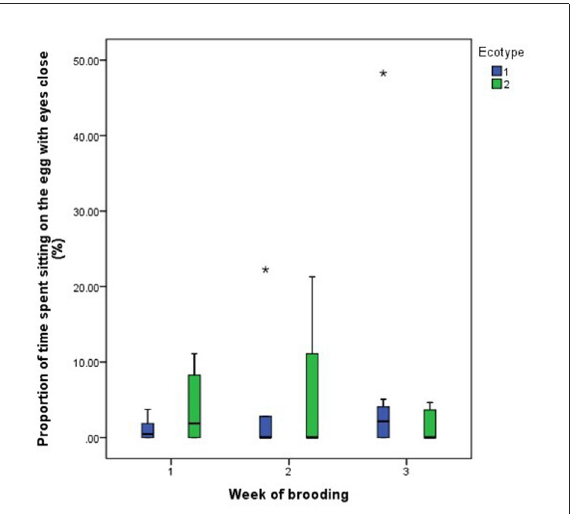
FIGURE8 Proportion of time spent by two Nigerian indigenous hen ecotypes (1 = Yoruba and 2 = Fulani) sitting on the eggs with eyes close over the three weeks of brooding. Outliers in the data are depicted by the symbol “*”.